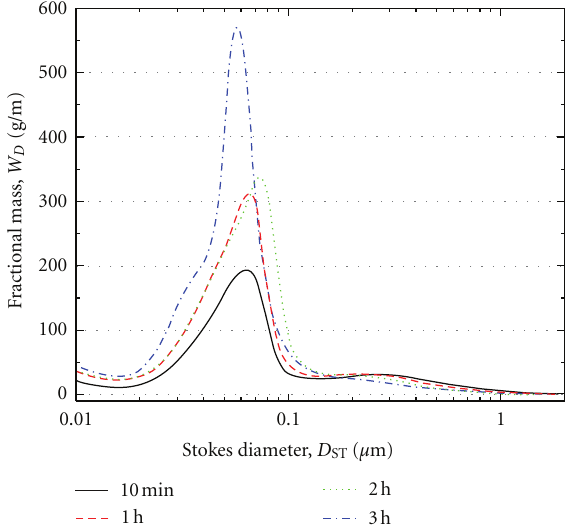
Figure 4: Particle size distributions of Arkema CNTs with increas- ing sonication time using a horn sonicator with flow cell at 40% amplitude.